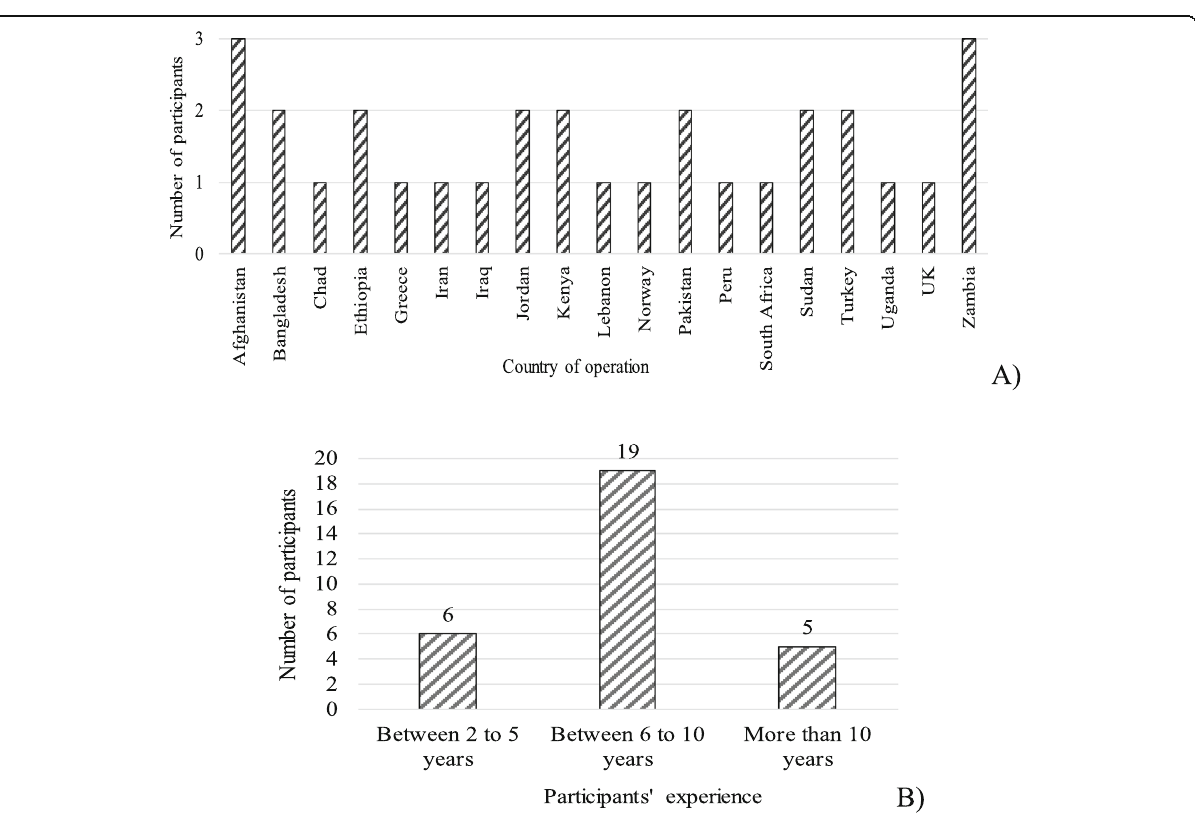
Fig. 2 a Location and b experience of the survey